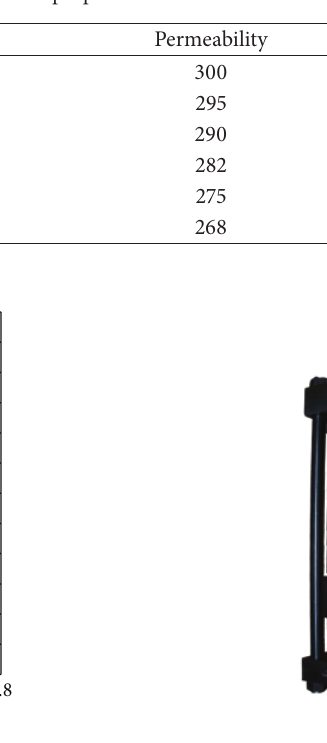
Figure 4: Curve between shear stress and magnetic induction. Figure 5: The photo of SDMR